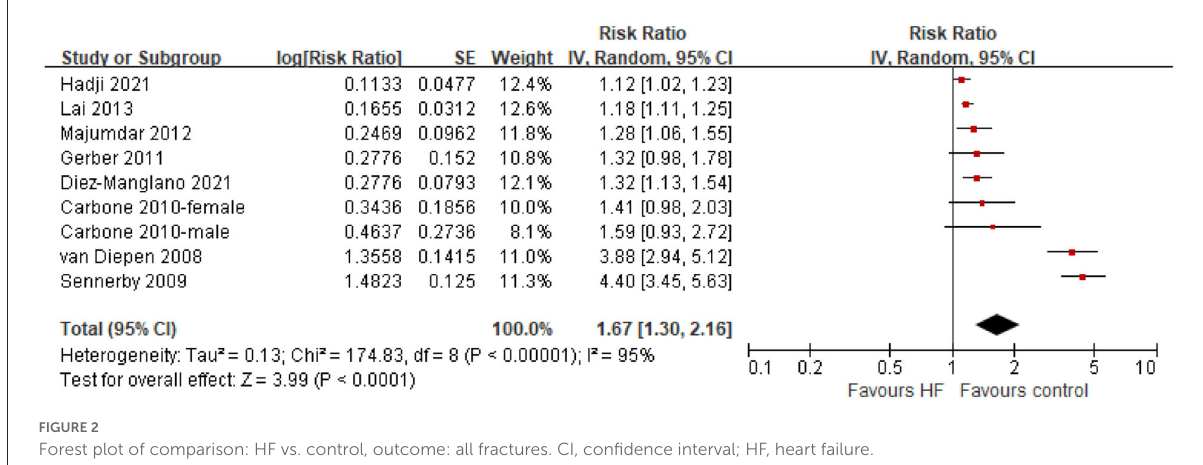
FIGURE2 Forest plot of comparison: HF vs. control, outcome: all fractures. CI, confidence interval; HF, heart failure.